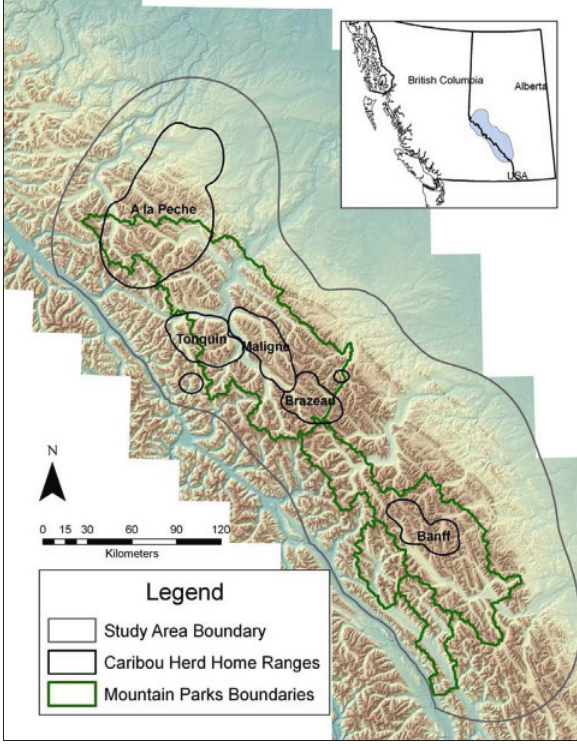
Fig. 1. Annual 99% adaptive kernel home ranges of five wood- land caribou herds utilizing Banff and Jasper National Parks, Alberta (2001 -